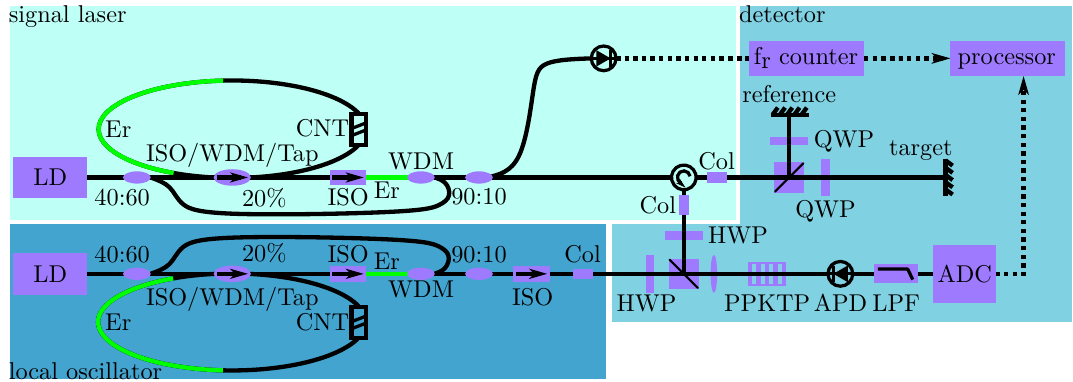
Figure 4. Absolute ranging system based on a pair of free running femtosecond lasers. LD (laser diode); ISO (isolator); WDM (wavelength division multiplexing); ISO/WDM/Tap (integrated ISO, WDM and tap with 20% transmittance); CNT (carbon nanotube); Er (Er fiber); Col (collimator); HWP (half wave plate); QWP (quarter wave plate); PPKTP (periodically-poled potassium titanyl phosphate); APD (avalanche photo diode); LPF (low pass filter); ADC (analog-to-digital